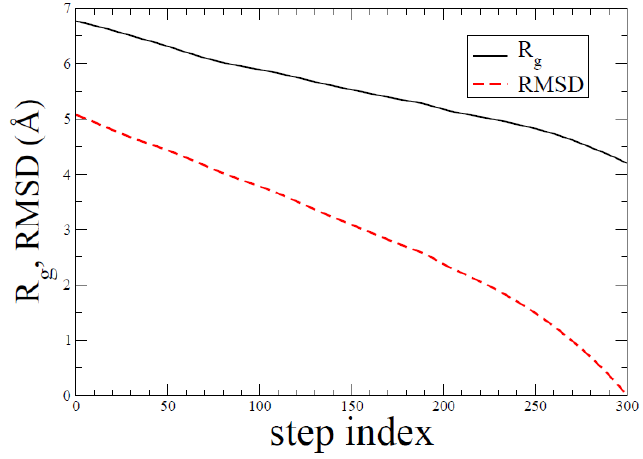
and root-mean square deviation (RMSD) values in Å are shown Figure 3. Calculated R g along the ADMD step index. We observe that R and RMSD are g